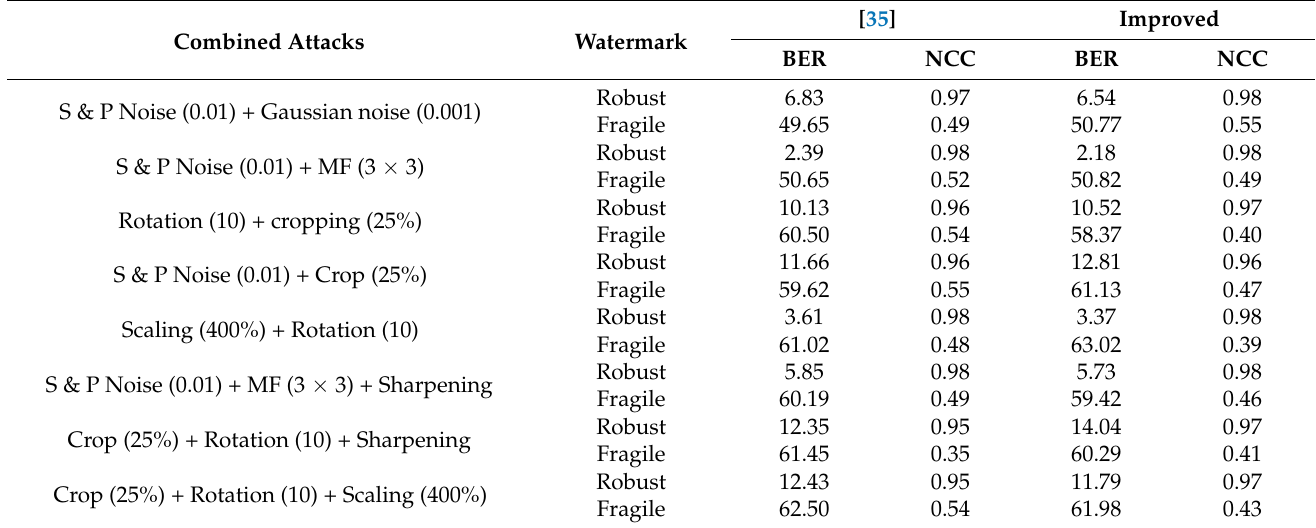
Table 5. Performance analysis of improved scheme and original scheme under mixed